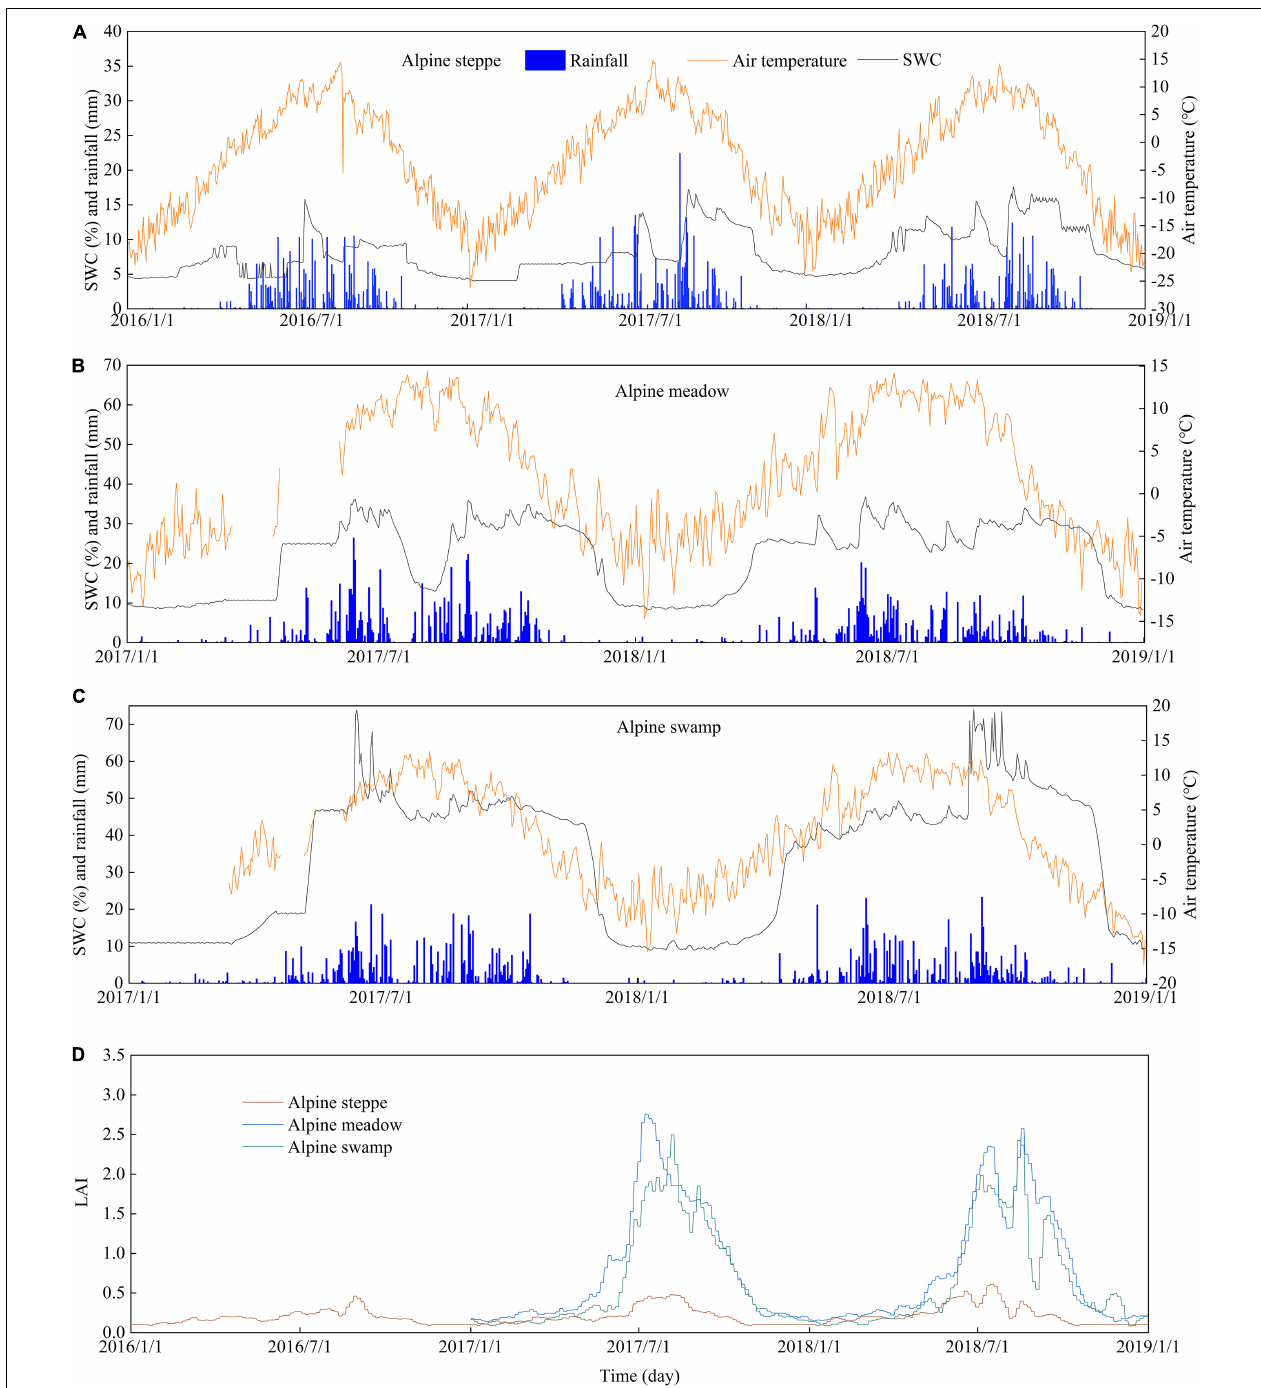
FIGURE 2 | Daily time series of air temperature, rainfall, and soil water content at 20-cm depth at the (A) alpine steppe, (B) alpine meadow, and (C) alpine swamp sites, and (D) leaf area index (LAI) at the alpine steppe, alpine meadow, and alpine swamp sites. Note that the y -axis scales vary among panels for better